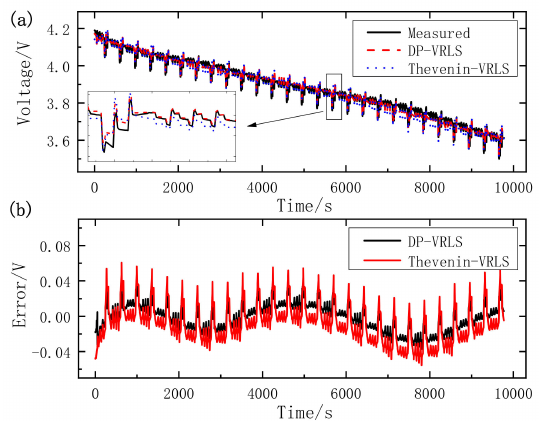
Figure 5. The estimated terminal voltages and corresponding errors based on different battery models under DST condition: ( a ) voltage comparison; ( b ) error of